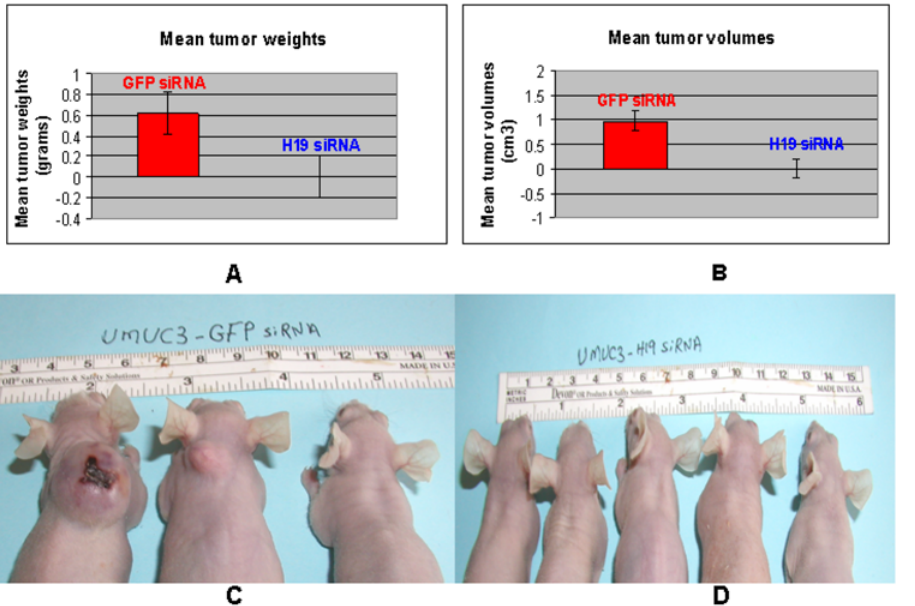
Figure 6. The in vivo effect of H19 silencing on the tumorigenic potential of human bladder carcinoma cells-UMUC3. One million UMUC3 cells were injected subcutaneously to athymic mice (n=3 for GFP siRNA, and 5 for H19 siRNA ), 48 hours after transiently transfected with siRNAs. Palpable tumors were observed 6 weeks later in 2 out of 3 mice of the GFP siRNA group, while in none of the H19 siRNA group . Mice were sacrificed 8 weeks after inoculation. Mean tumor volumes (B, P , 0.05), and mean tumor weights (A, p , 0.06) are depicted. Values represent end-points just before and after sacrificing animals. Pictures depict the external features of the tumors in mice inoculated with UMUC3 transfected with GFP siRNA (C), and H19 siRNA (D).